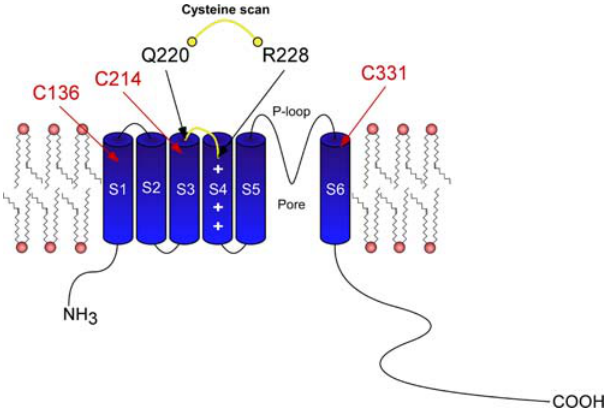
Figure 1. Schematic cartoon showing the S3–S4 linker and the S4 N-terminal region of the Kv7.1 channel where the cysteine scan was performed. In red labels are shown the three endogenous cysteines accessible from the external solution, which could potentially form metal or disulfide bridges (C136, C214 and C331, located in the S1, S3 and S6 transmembrane segments, respectively).